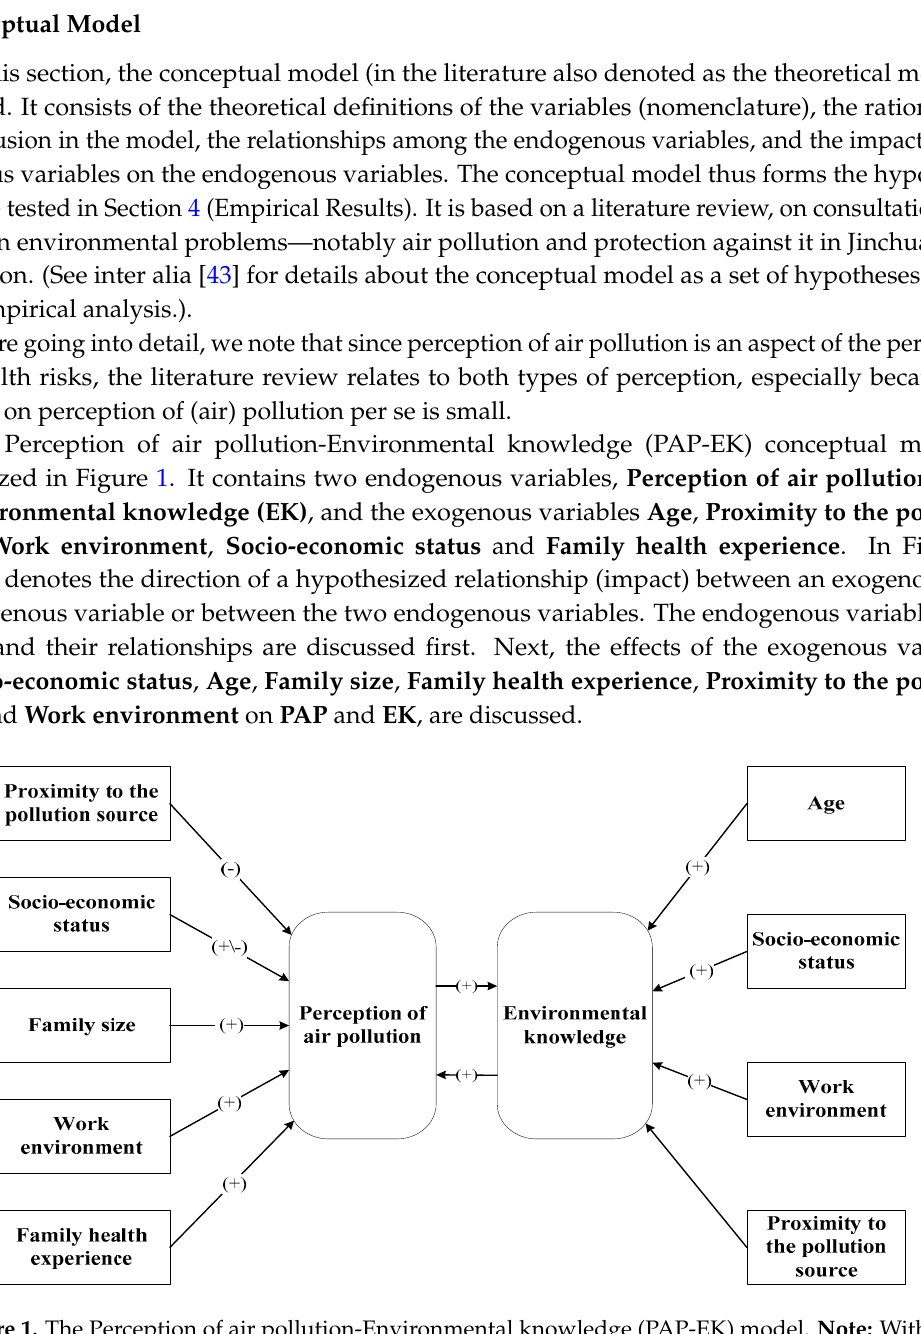
Figure 1. The Perception of air pollution-Environmental knowledge (PAP-EK) model. Note: Within the brackets are the expected